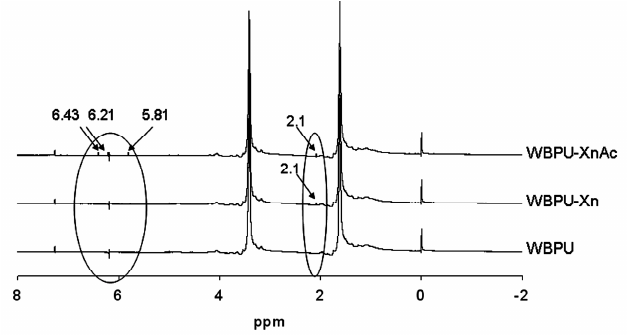
Figure 4. 1 H-NMR spectra of typical coatings.